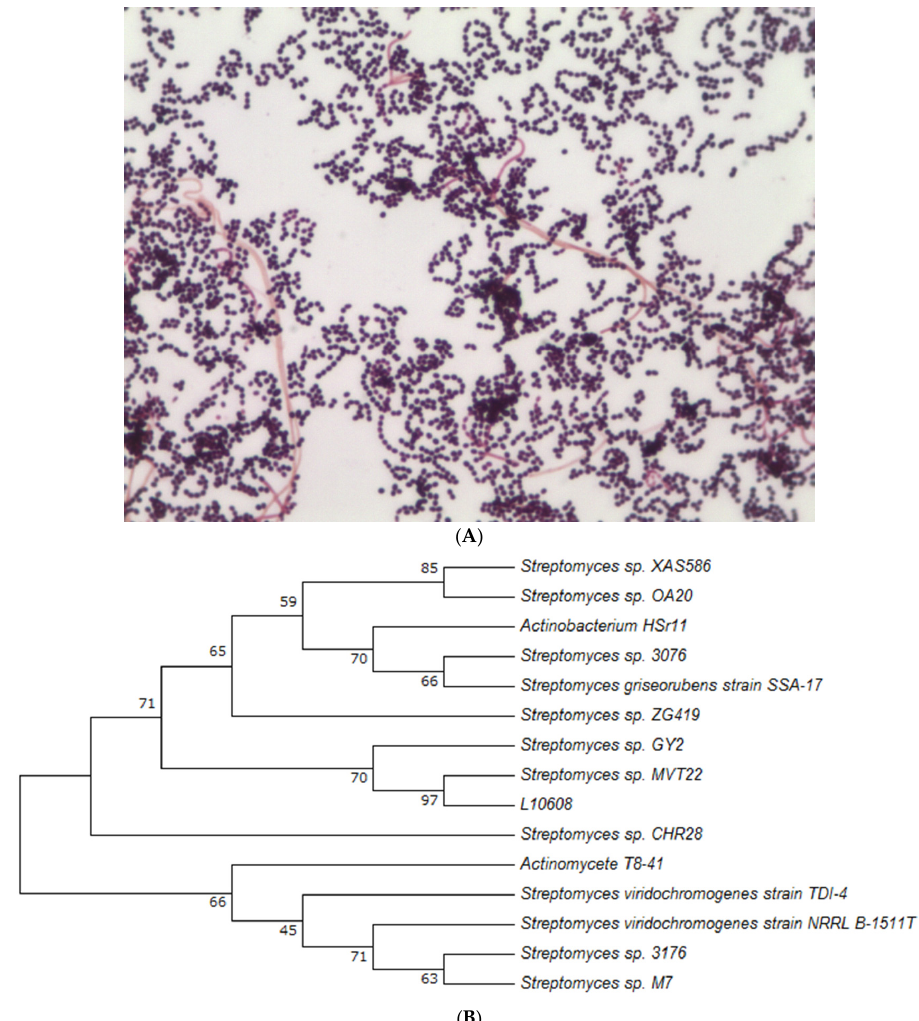
Figure 1. The morphological characteristics of strain L10608 on a microscope (1000×) ( A ) and phylogenetic tree of L10608 ( B ).